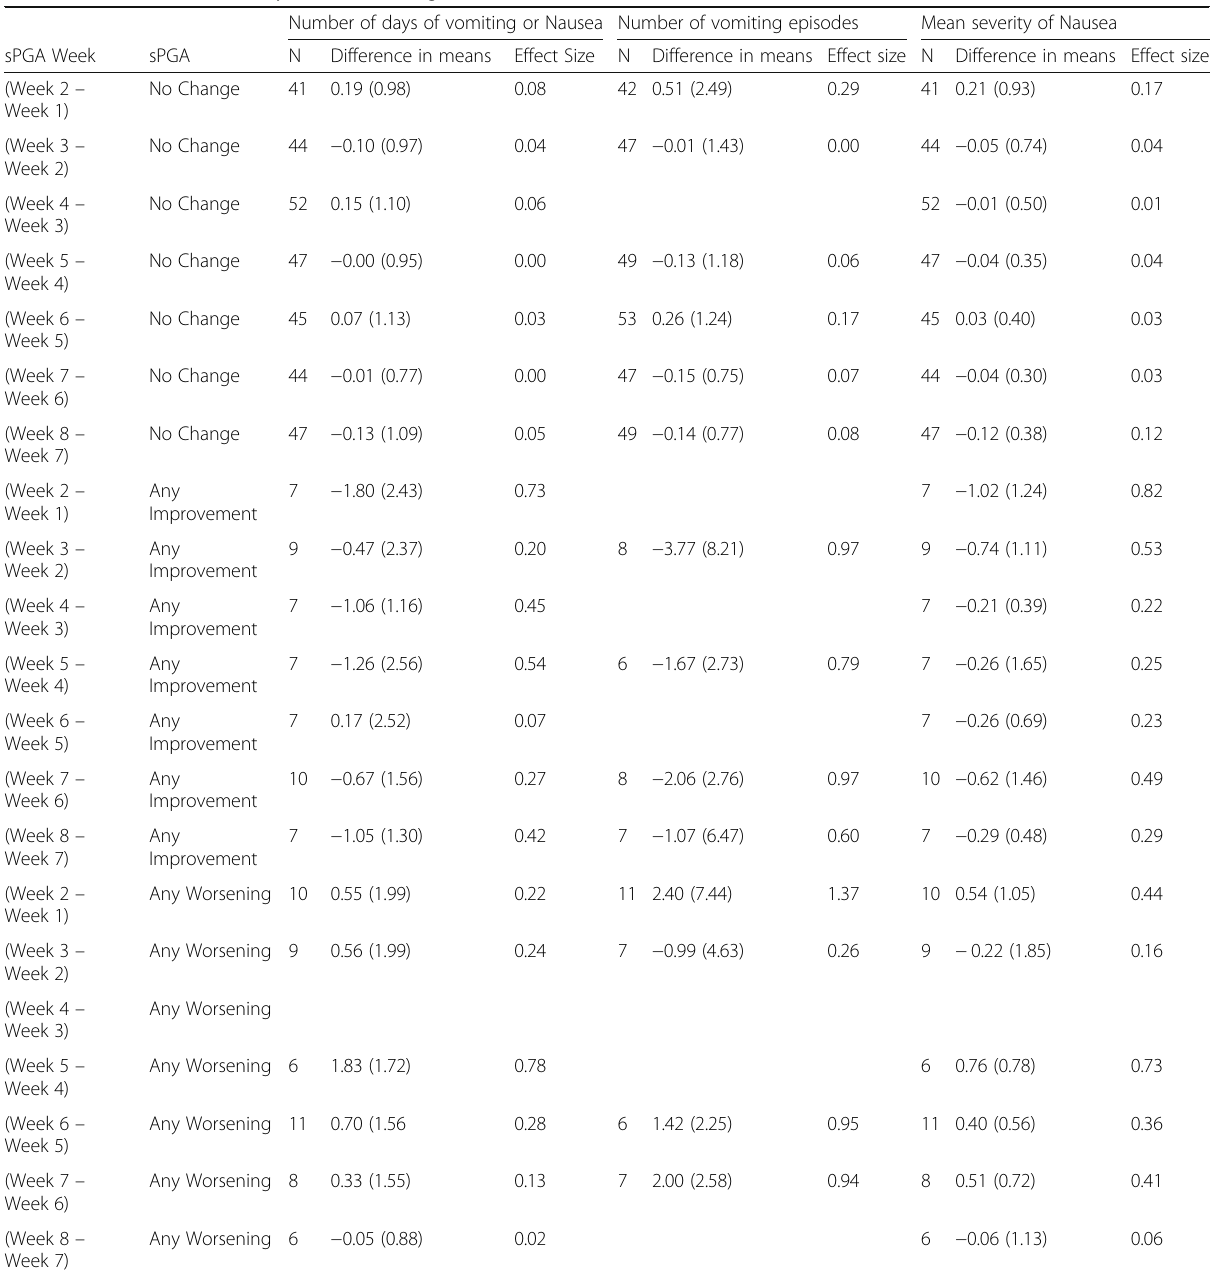
Table 10 Assessment of ability to detect change of NVSA © scores with the sPGA and effect size Number of days of vomiting or Nausea Number of vomiting episodes Mean severity of